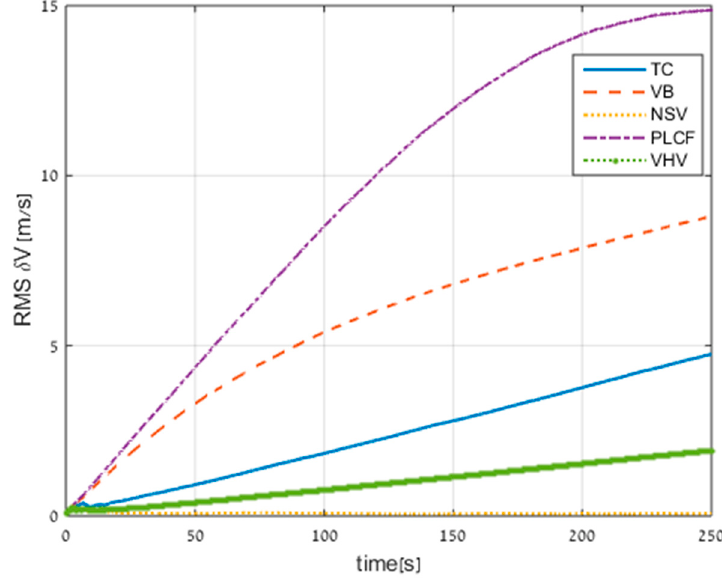
Figure 9. Root mean square (RMS) errors of velocity for all approaches obtained from trajectory #1. TC: tightly coupled.